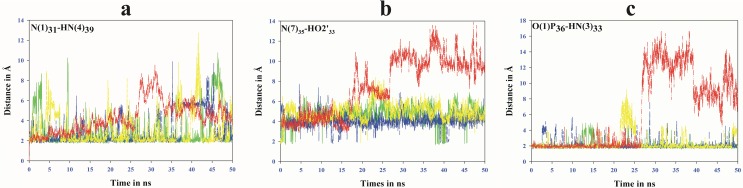
Hydrogen bonding interactions within ASL of tRNALeu.